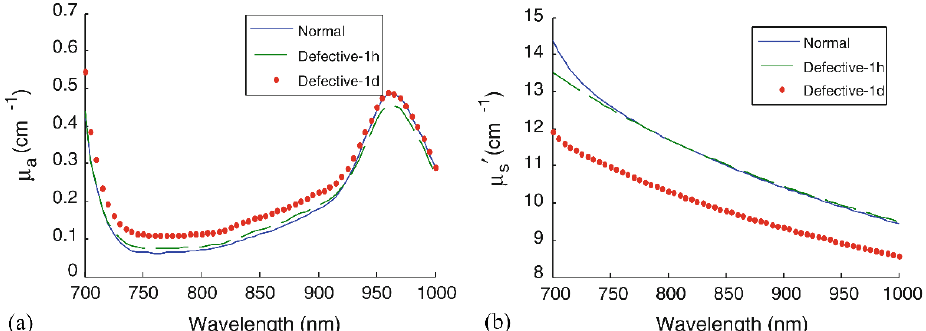
Figure 24. Mean spectra of ( a ) µ a and ( b ) µ (cid:48) s of 50 normal and defective ‘Journey’ pickling cucumbers measured at different times after mechanical damage (1 h and 1 day). Reproduced with permission from [91], Copyright Springer, 2011.